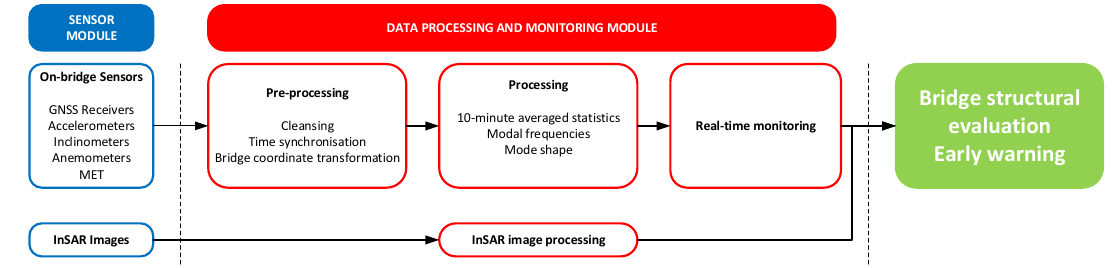
Figure 6. Key functionalities of GeoSHM data processing and monitoring module.